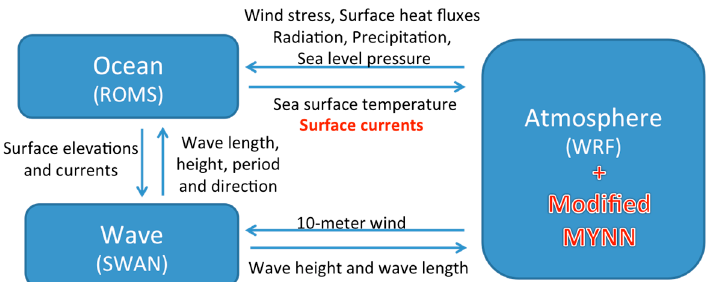
Figure 1. Coupled-Ocean-Atmosphere-Wave-Sediment Transport (COAWST) configuration and exchanged data fields. We modified the COAWST coupling so that WRF can use current-relative wind for stress calculation. SWAN was already designed to use the current relative winds. Our changes are highlighted in red.